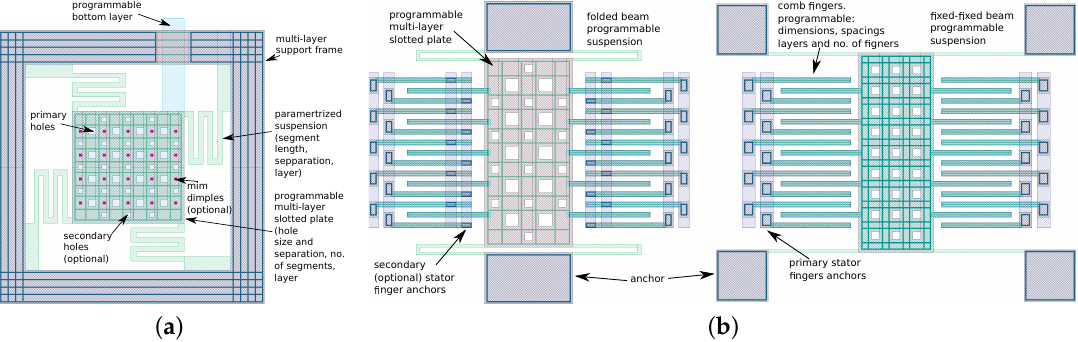
Figure 4. Parameterized cells examples: z -axis two-plate device ( a ); and two cases of lateral x / y -axis devices with folded beam and fixed-fixed suspension ( b ).